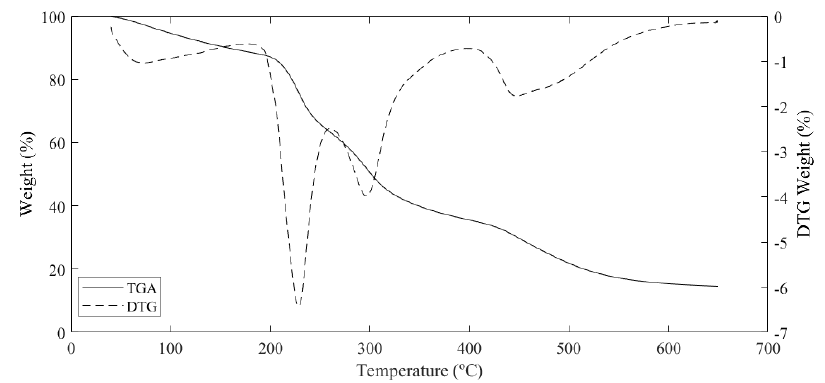
Figure 4. TGA and DTG curves of Haden mango peel pectin.